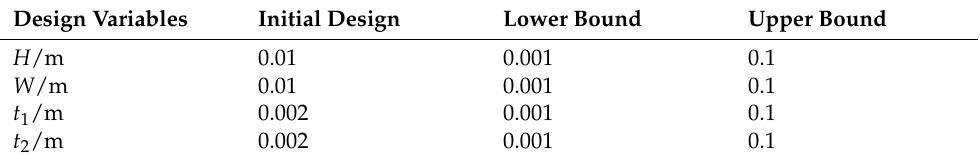
Table 2. Design variables.